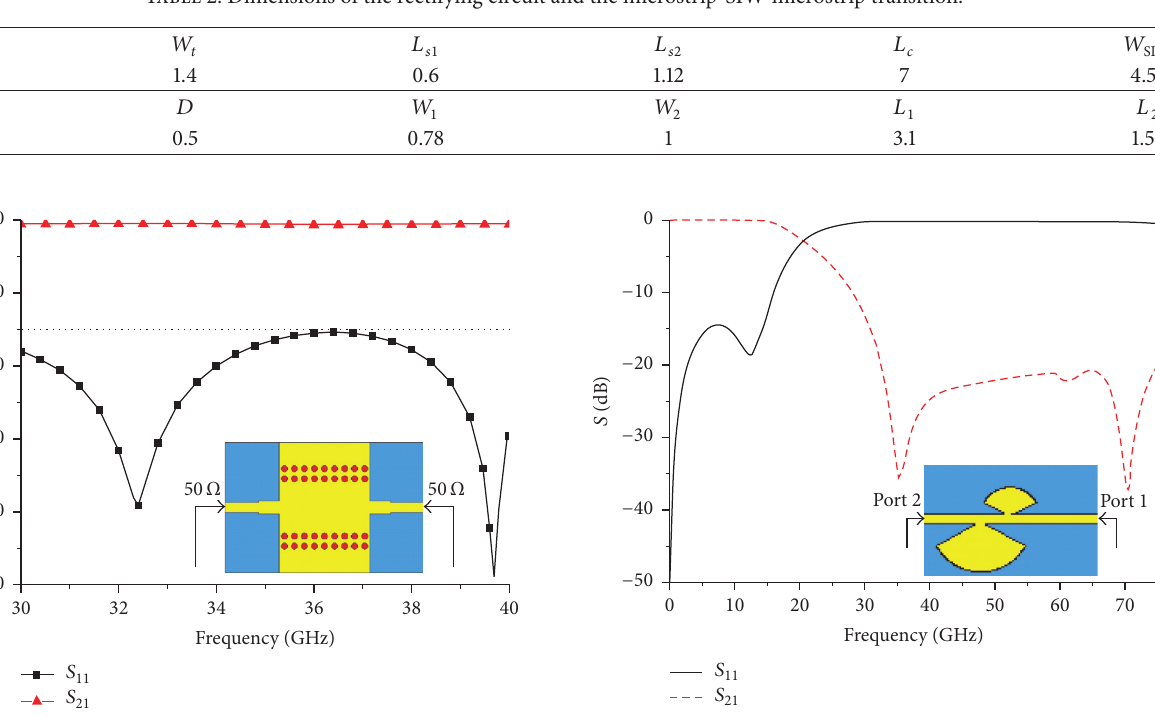
Table 2: Dimensions of the rectifying circuit and the microstrip-SIW-microstrip transition.